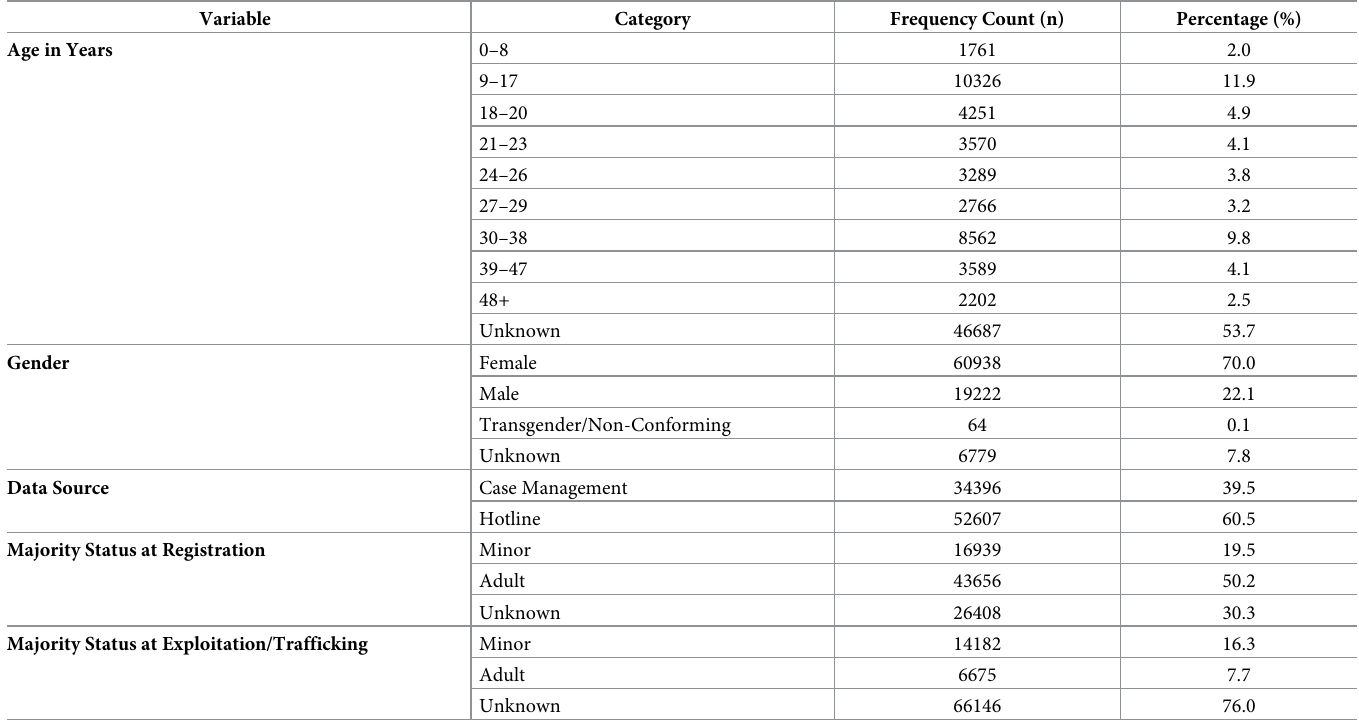
Table 1. Sociodemographic profile of victims in the period 2010–2020 (n =